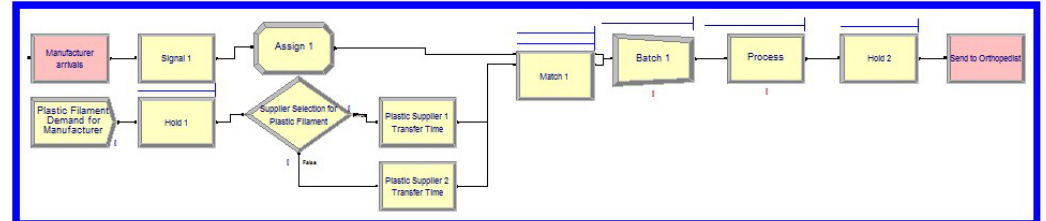
Figure 14. Supplying filament and producing insoles with 3D printer.